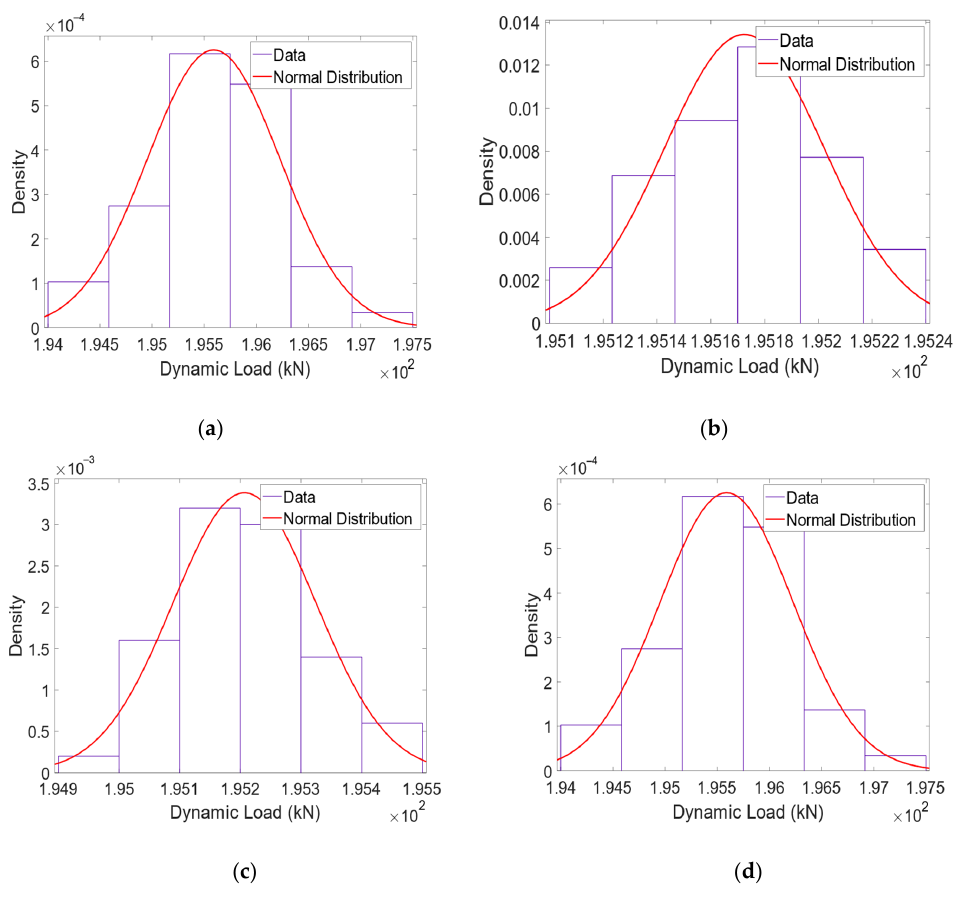
Figure 11. Normal distribution of dynamic loads for different speeds: ( a ) 5 m/s; ( b ) 10 m/s; ( c ) 20 m/s; ( d ) 40 m/s. ( c ) 20 m/s; ( d ) 40